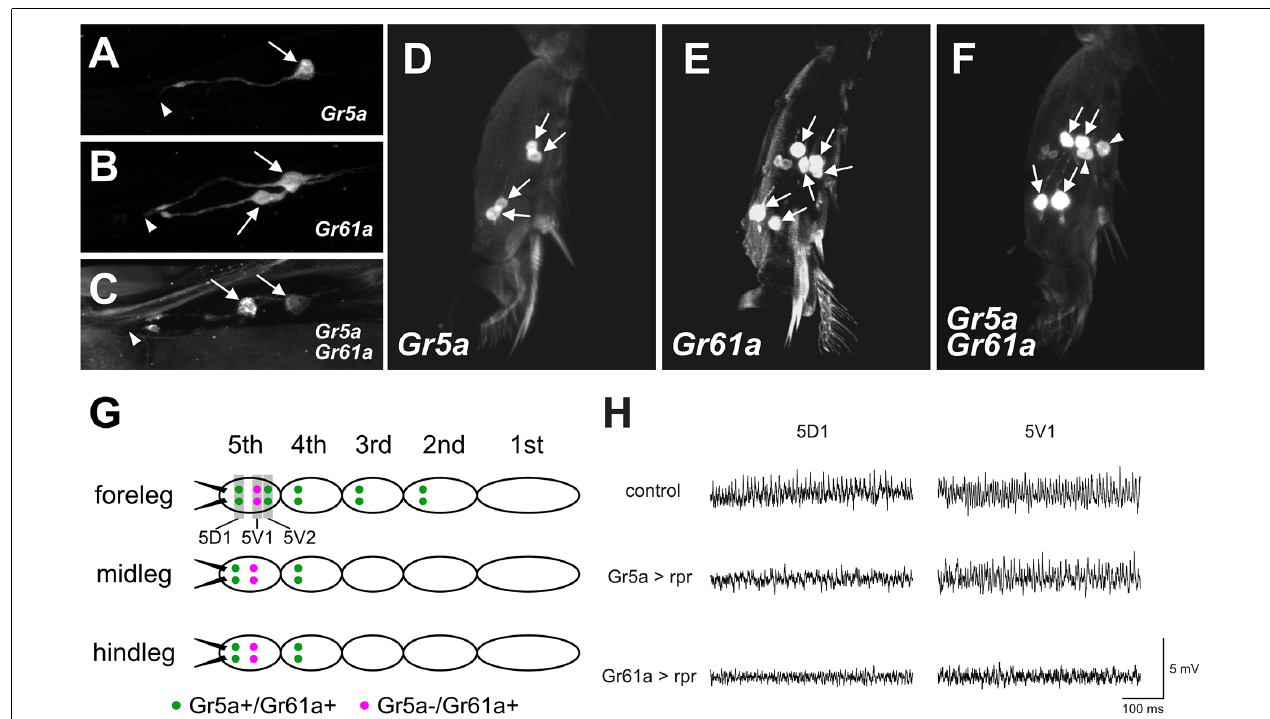
FIGURE 3 | Gr5a and Gr61a are coexpressed in some GRNs in the LSO and legs. (A–C) Projection images of optical sections of the LSO. GRNs are labeled by UAS-mCD8::GFP driven by Gr5a-Gal4 (A) , Gr61a-Gal4 (B) , and both Gr5a-Gal4 and Gr61a-Gal4 (C) . Arrows and arrowheads indicate the cell bodies of labeled GRNs and the location of the cuticular pore structure of 7th sensillum of LSO, respectively. (D–F) Projection images of optical sections of the 5th tarsal segment of the foreleg. GRNs are labeled by UAS-mCD8::GFP driven by Gr5a-Gal4 (D) , Gr61a-Gal4 (E) , and both Gr5a-Gal4 and Gr61a-Gal4 (F) . (G) A schematic illustration of the distribution of Gr5a +/ Gr61a + GRNs and Gr5a − / Gr61a + GRNs in the legs. Ten Gr5a +/ Gr61a + GRNs are distributed in 2nd to 5th segments of the foreleg, and four Gr5a +/ Gr61a + GRNs are located in the 4th and 5th segments of the midleg and hindleg (green dots). Two Gr5a − / Gr61a + GRNs are distributed in the 5th segment of each leg (purple dots). (H) Electrophysiological responses to sugar solution recorded from 5D1 and 5V1 tarsal taste hairs. Representative records obtained from adult females with genotypes w 1118 (control), w 1118 ; Gr5a-Gal4/UAS-rpr; UAS-mCD8::GFP/+ (Gr5a >rpr) and w 1118 ; Gr61a-Gal4/UAS-rpr; UAS-mCD8::GFP/+ (Gr61a >rpr) are shown. 50 mM sucrose solution was used as a stimulant. Female flies were used for all the histological observations and electrophysiological